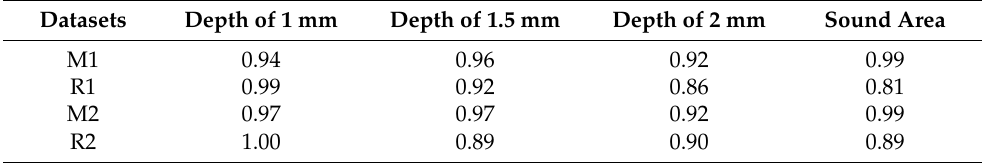
Figure 13. The normalized confusion matrix of test datasets from (a) R1; (b) R2. Table 3. The results of defect depth recognition based on the GRU model. Datasets